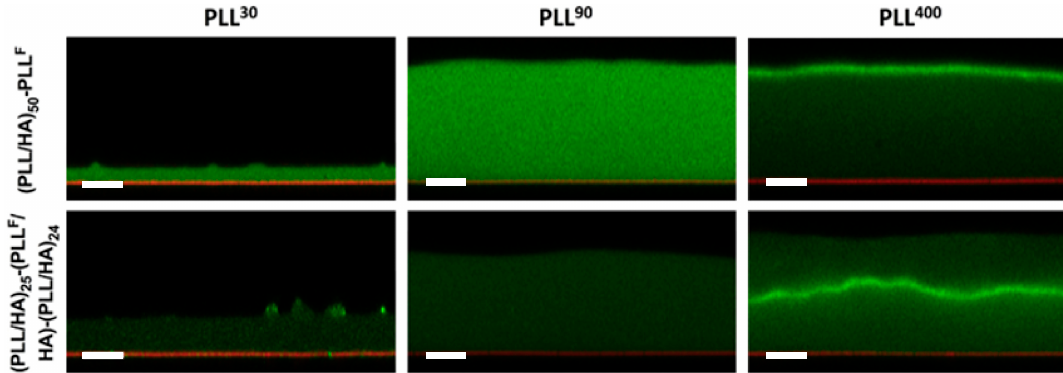
Figure 5. Examining PLL mobility within (PLL / HA) 50 films using CLSM and FRAP experiments: cross-sectional CLSM images of (PLL / HA) 50 -PLL F (top) and (PLL / HA) 25 -(PLL F / HA)-(PLL / HA) 24 films (bottom) assembled with PLL 30 , PLL 90 , and PLL 400 (left to right). Green indicates PLL F and red indicates the glass substrate. The scale bar is 10 µ m. Figure taken from reference [129], Copyright © 2020 John Wiley and Sons Ltd.